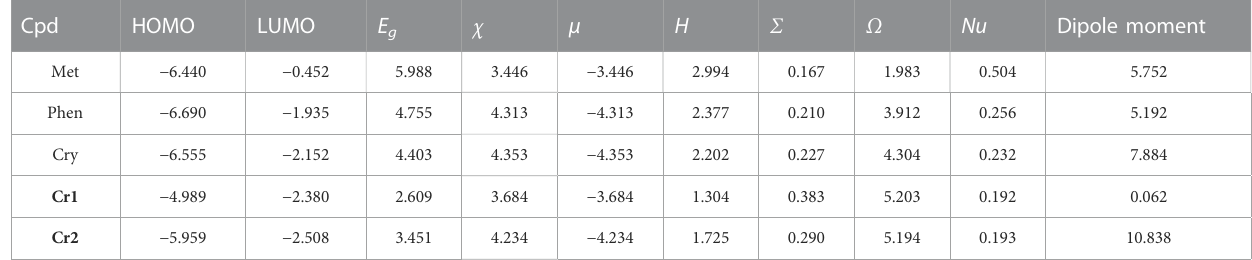
TABLE 3 Quantum chemical descriptors of the ligands and Cr(III) complexes: band gap (eV), electronegativity (eV), electronic chemical potential (eV), global chemical hardness (eV), global softness ( σ = eV -1 ), global electrophilicity index (eV), nucleophilicity index (eV -1 ), and dipole moment (Debye). Cpd HOMO LUMO E g χ μ Η Σ Ω Nu Dipole moment Met −